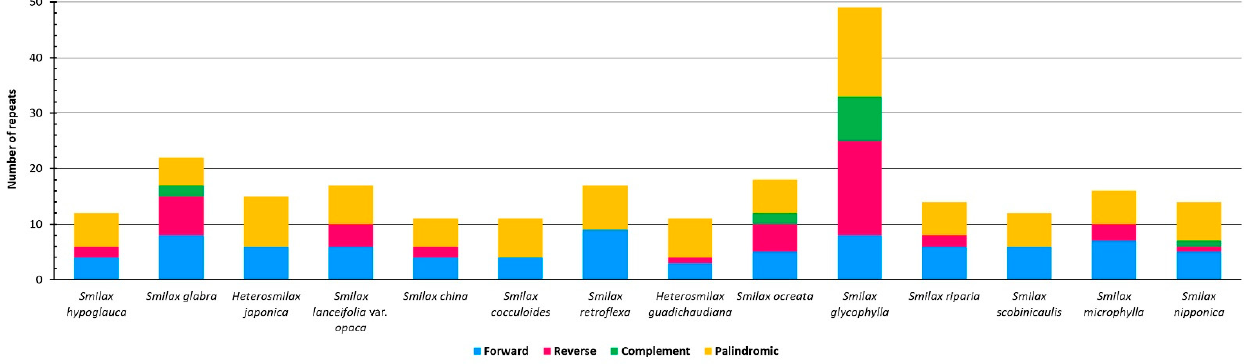
Figure 3. Types of LTRs detected from fourteen Smilacaceae species.